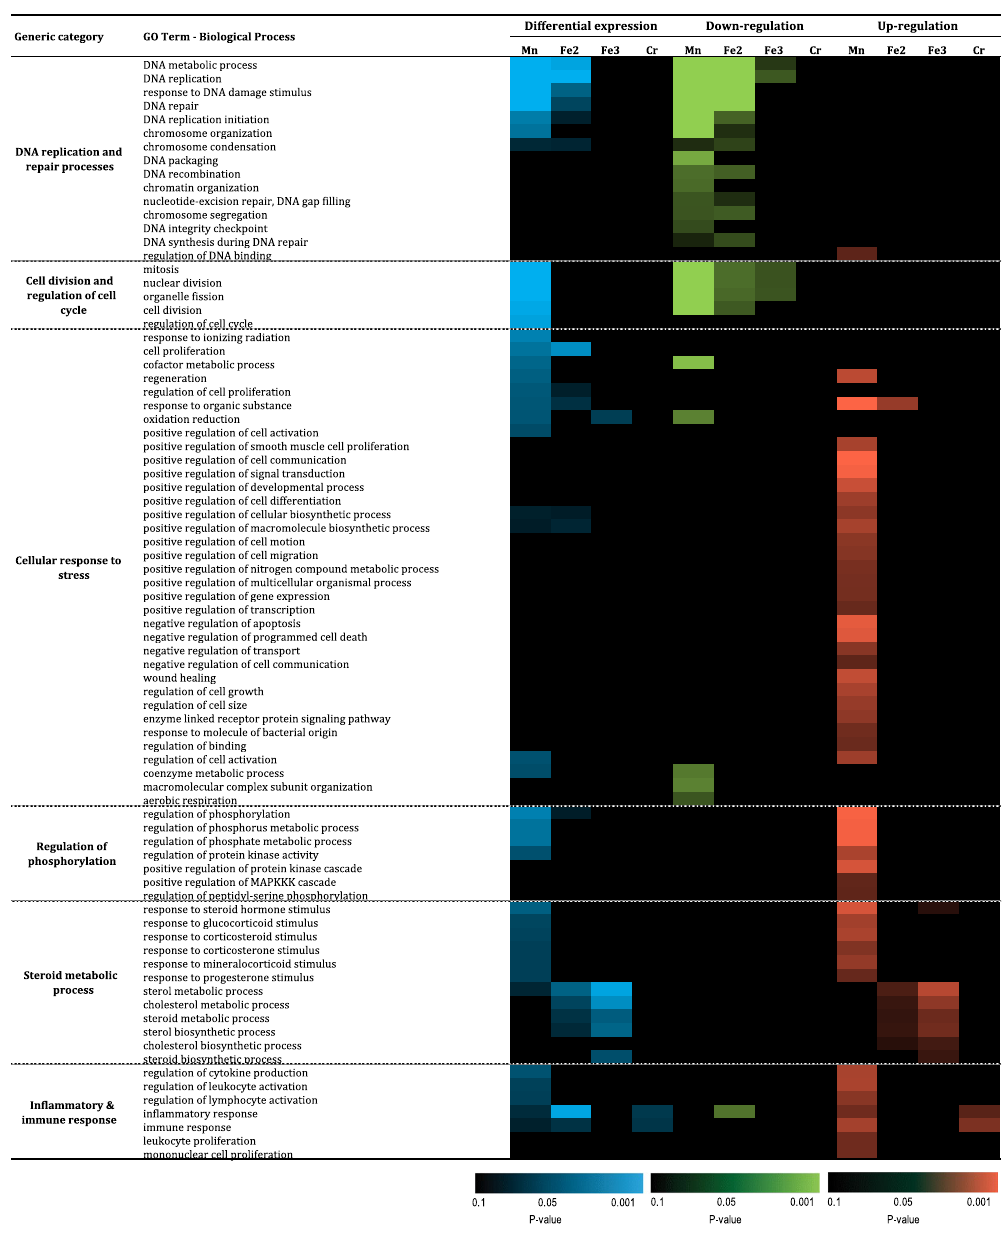
Figure 6. Functional enrichment of significantly regulated genes: biological process GO-terms. Abbreviations as in Fig.